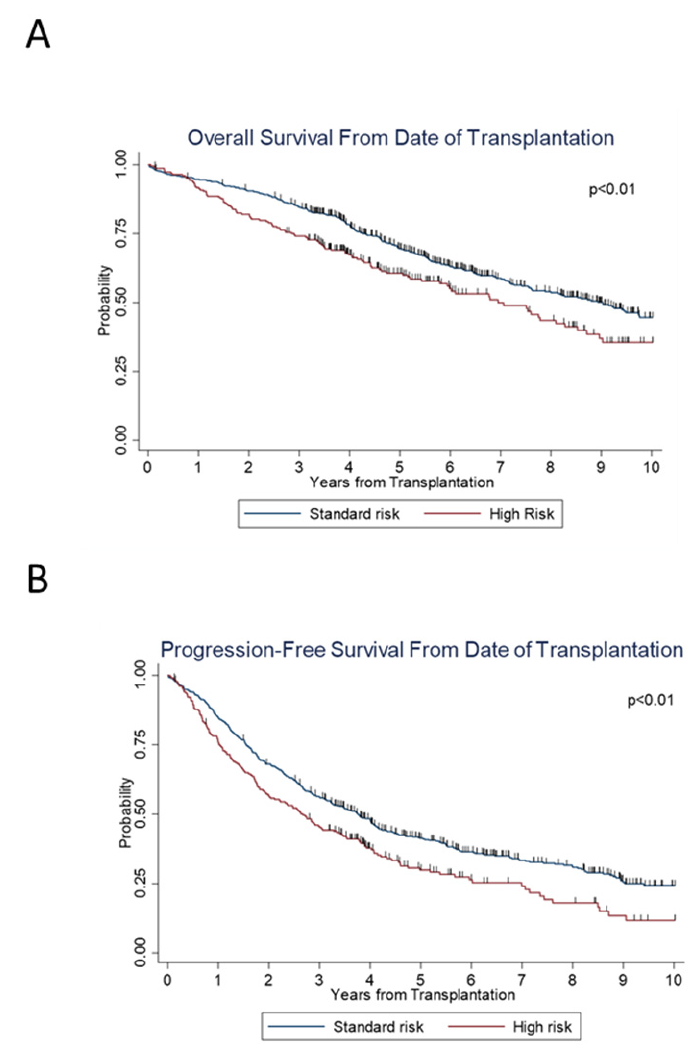
Figure 3. Survival outcomes between standard versus high risk patients. Furthermore, the rate of response both pre- and post-transplant showed statistically significant improvement across the years ( p < 0.01). The post-transplant response (VGPR or better) also increased from 28.9% in group 1 to 76.3% in group 5 (Table 1). Multivariable analysis showed that transplant year, pre-transplant remission status, International Staging System (ISS), and high- versus standard-risk cytogenetics have significant contributions to the risk of relapse or death (Tables 2 and 3). Patients who received transplant between 2009–2013 and between 2014–2016 had a significantly lower risk for relapse or death, HR 0.49 (95% CI 0.38–0.62), and 0.53 (95% CI